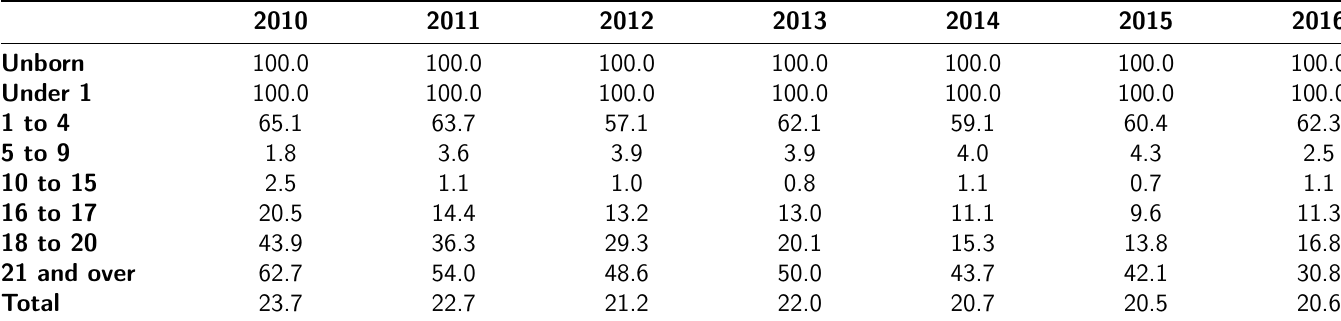
Table 1: Percentage of children in need per age group per year missing from SAIL records